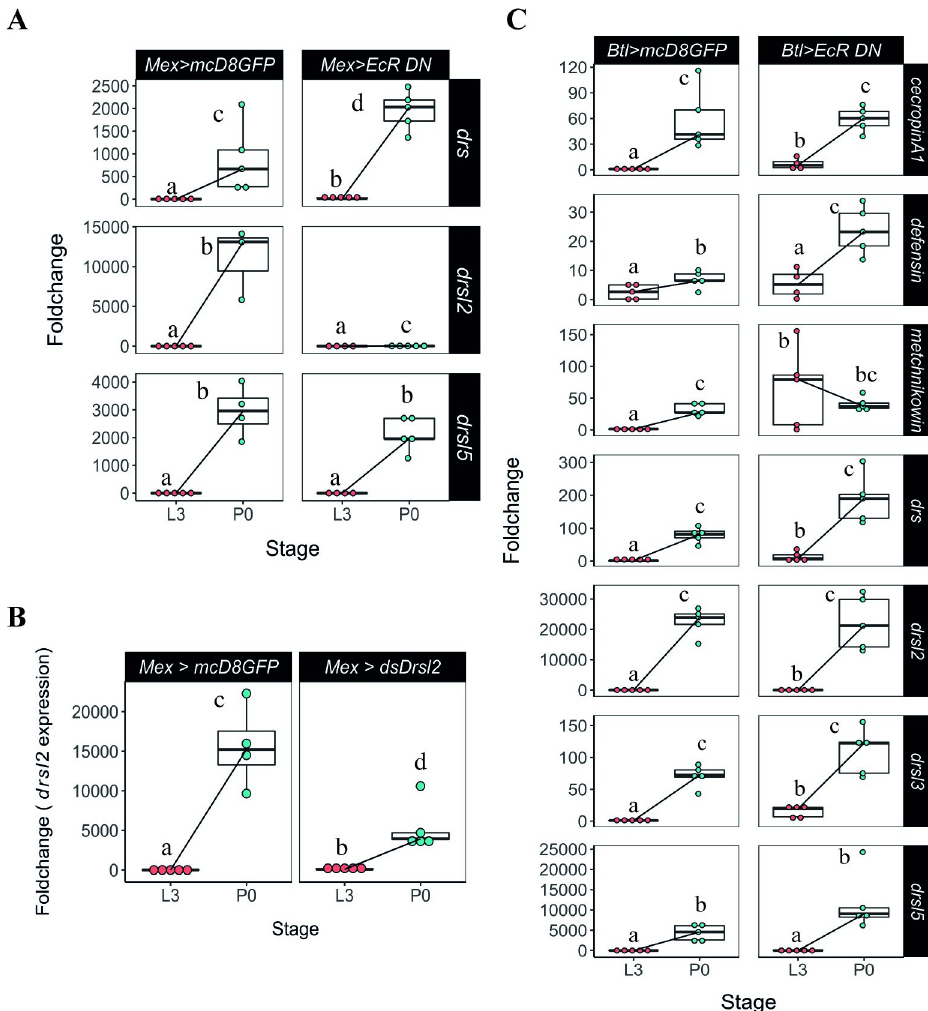
Fig 4. Gut and tracheal expression of relevant AMPs. (A) Manipulation of ecdysone sensitivity specifically in the midgut reduced the expression of drsl2 ( lsmeans(pairwise~Genotype|P0) < 0 . 0001; lsmeans(pairwise~Stage|Mex > EcRDN) < 0 . 0001 )), but not of drs ( lsmeans(pairwise~Stage|Mex > EcRDN) < 0 . 0001 )or drsl5 (( lsmeans (pairwise~Genotype|P0) < 0 . 4479; lsmeans(pairwise~Stage|Mex > EcRDN) < 0 . 0001 )(See also S7 Table). (B) Knock-down of drsl2 specifically in the midgut resulted in an overall decrease in the expression of this AMP ( lsmeans (pairwise~Genotype|P0) < 0 . 0237; lsmeans(pairwise~Stage|Mex > ds-drsl2) < 0 . 0001 ). Each dot represents a sample of five pooled individuals; the lines connect the median of the samples at L3 and P0. (C) Ecdysone signalling in the trachea does not affect the expression of any AMP under study ( lsmeans(pairwise~Stage|btl > EcRDN) < 0 . 0001 for all AMPs, except metchnikowin ( pairwise~Genotype|P0) < 0 . 6789; lsmeans(pairwise~Stage|btl > EcRDN) = 0 . 3711)) . (See also S8 Table). Foldchange was determined using the ΔΔ CT method. Different letters represent statistically significant differences in foldchange.